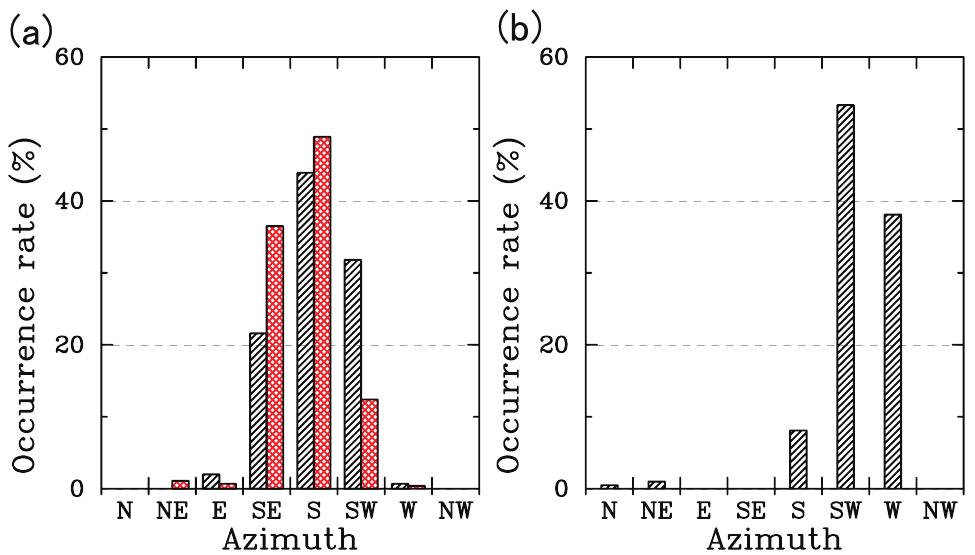
Fig. 4. Propagation direction of the (a) daytime and (b) nighttime MSTIDs at (red) higher and (black) lower latitude regions of Europe in 2008. Note that the nighttime MSTIDs were not observed in the higher latitude